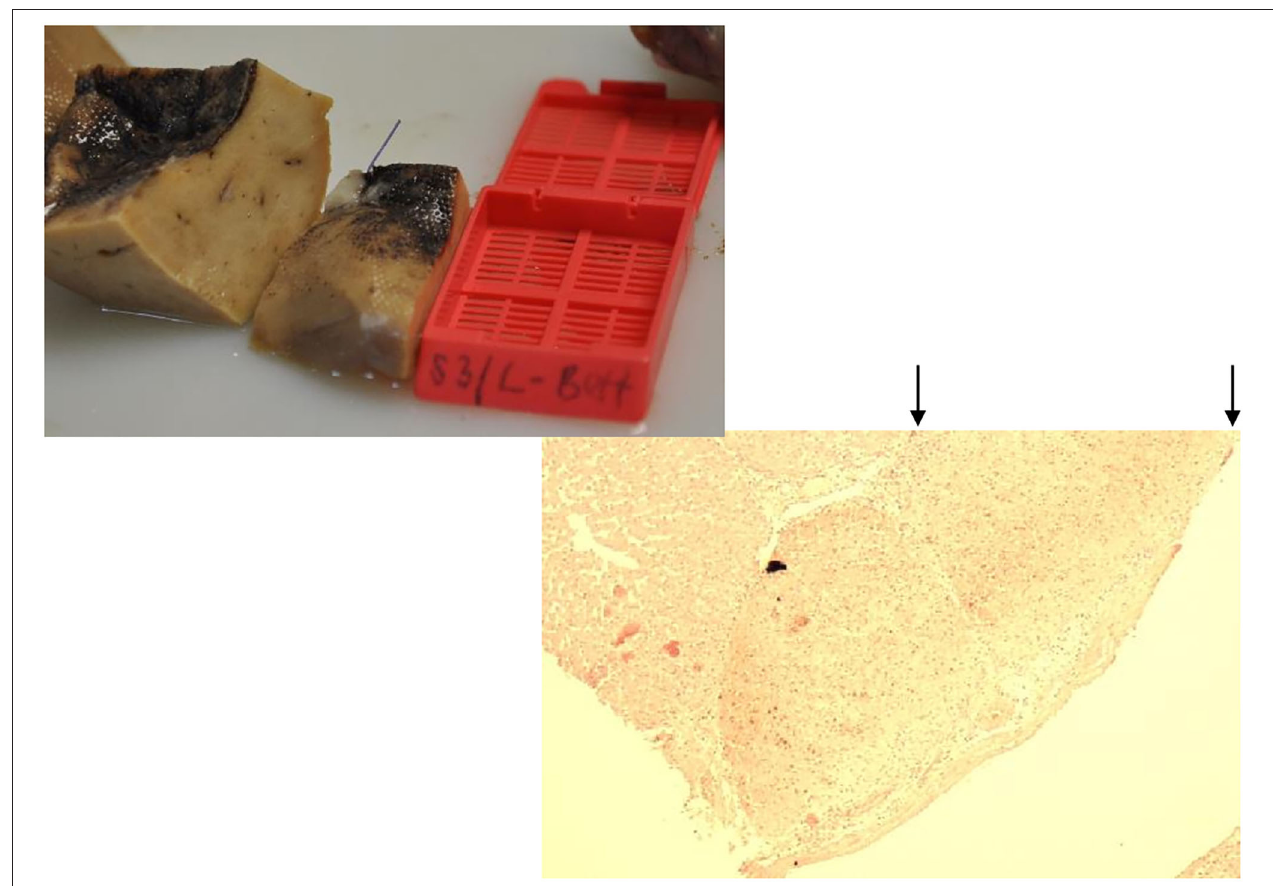
FIGURE 11 | Animal 3, − 80 mmHg. Histology from the liver bed: capsular and subcapsular inflammatory infiltrate with necrosis (marked by arrows). Intact liver parenchyma (bars).